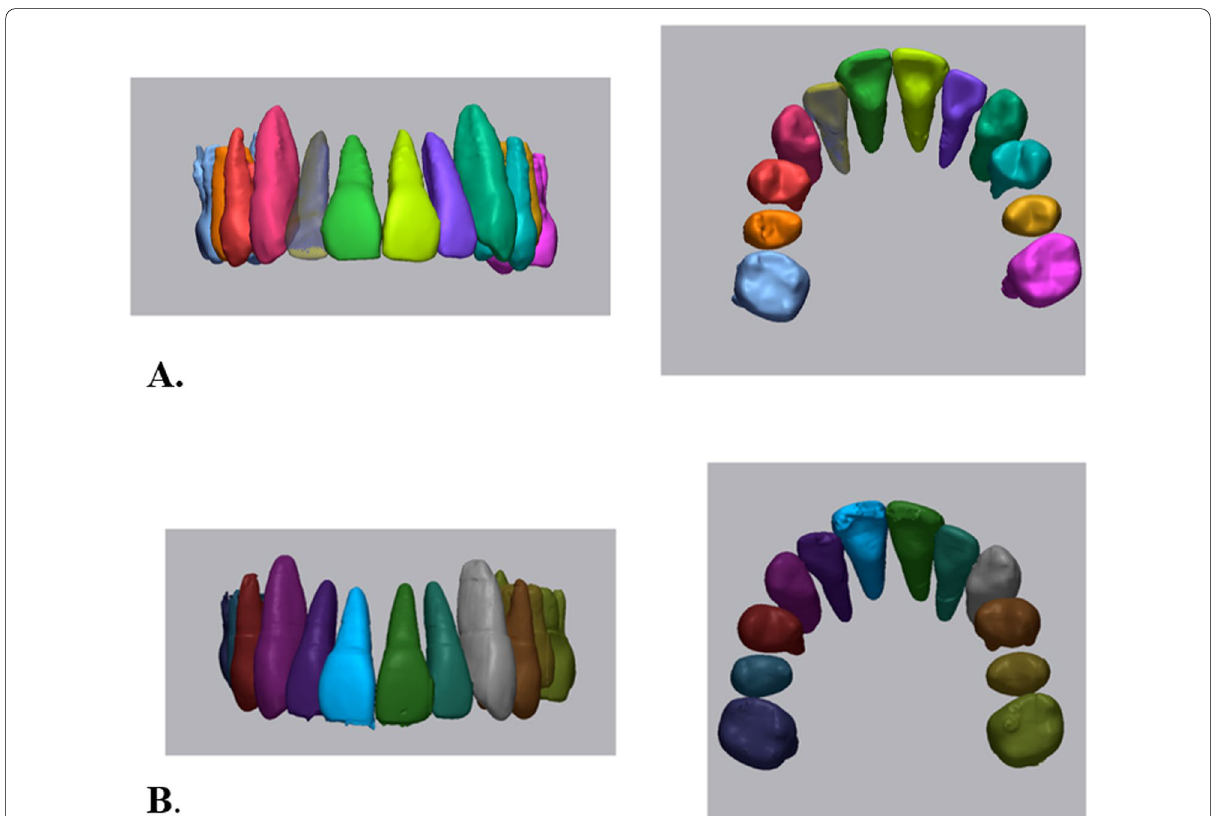
Fig. 2 Tooth segmentation using manual ( a ) and deep learning ( b ) segmentation